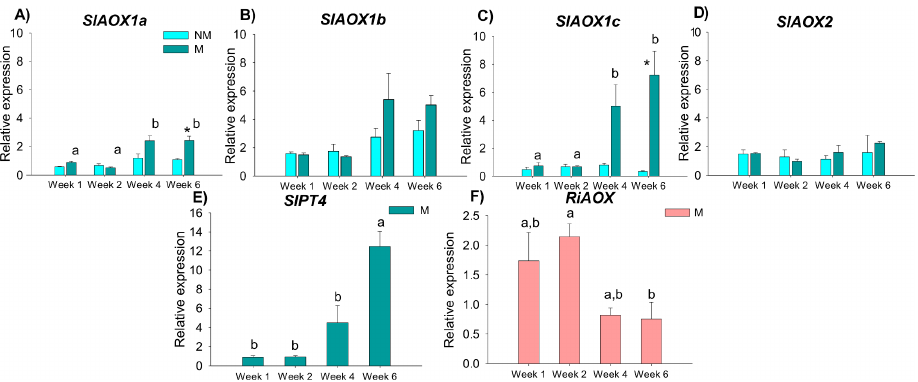
Fig 4. Expression levels of AOX gene family in mycorrhizal and non-mycorrhizal tomato roots. Expression levels were analysed at 1, 2, 4 and 6 weeks post-inoculation with R . irregularis . The expression levels of SlAOX1a (A), SlAOX1b (B), SlAOX1c (C), SlAOX2 (D) and SlPT4 (E) were analysed in roots of mycorrhizal and non-mycorrhizal tomato plants. The transcript levels of RiAOX were analysed on mycorrhizal roots of tomato (F). Asterisks ( * ) indicate significant differences ( P < 0.05) in expression between mycorrhizal and non-mycorrhizal roots at one time point. Different superscript letters (a, b) indicate significant differences ( P < 0.05) between weeks on mycorrhizal roots. No expression of SlPT4 and RiAOX was found in non- mycorrhizal